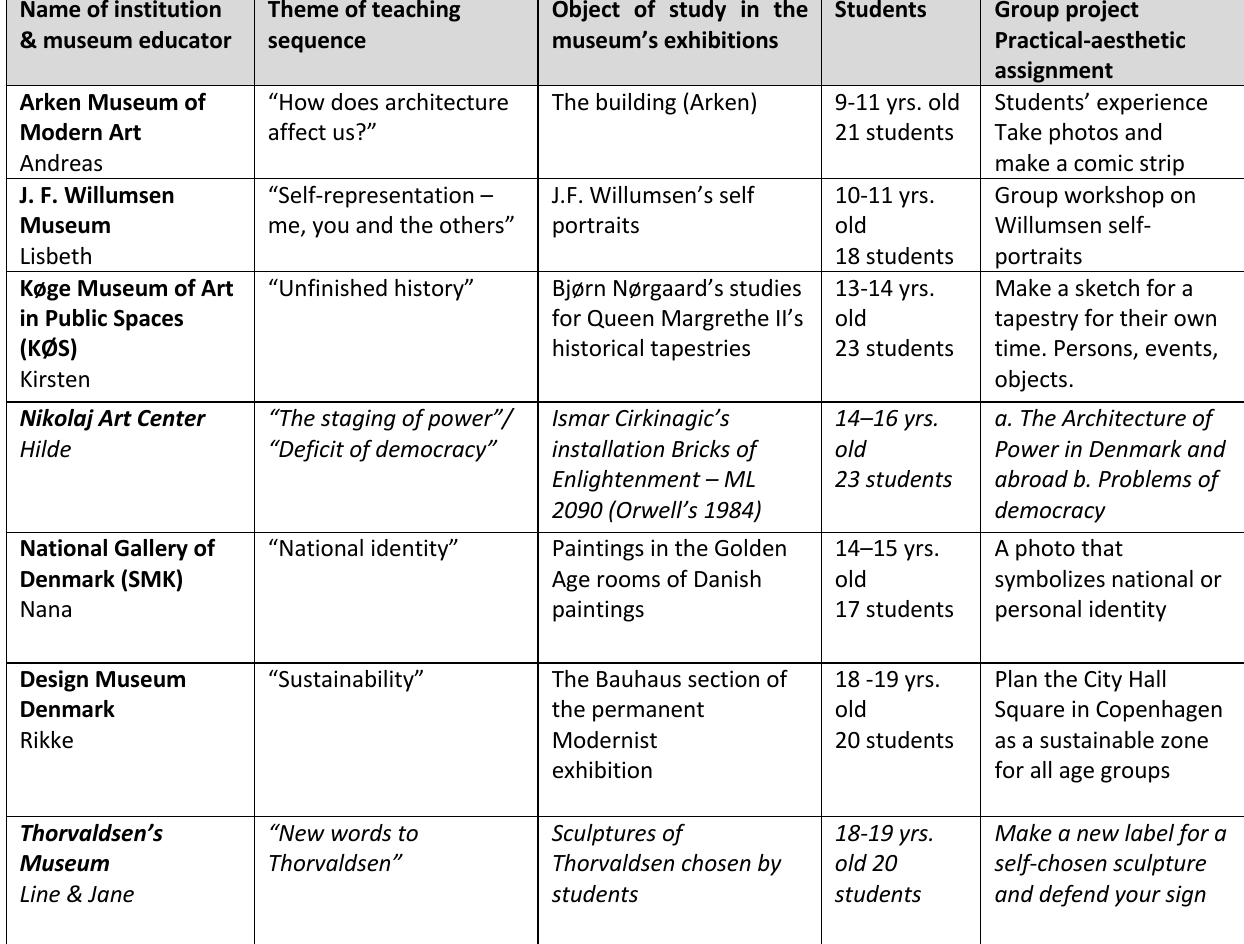
Table 1: Sites, data source, participants, project